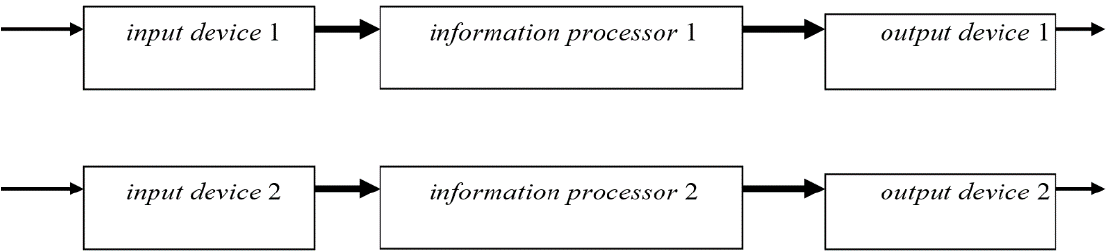
Figure 2. A schema of parallel information processing device hardware.